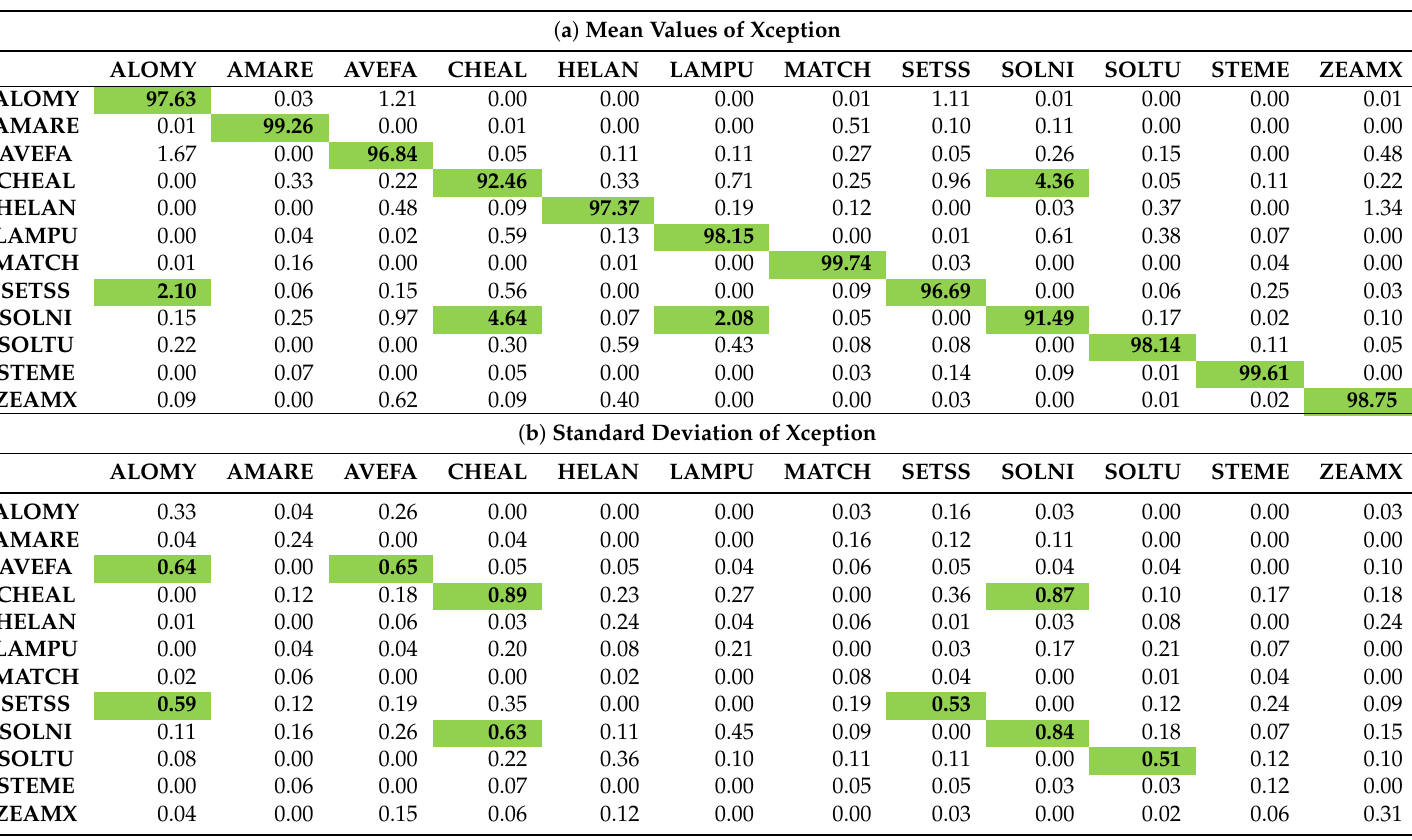
Table 5. Confusion matrix of the mean crop and weed identification for the Xception Convolutional Neural Network. The prediction reached between 97.5 and 97.8 % top-1 accuracy on the test dataset. The values are the percentage of identified labels for each plant species (Each row sums to 100%). ( a ) Mean values for the ten training runs. Cell values above 2% are highlighted. ( b ) Standard deviation for the ten training runs. The standard deviation values above 0.5% are